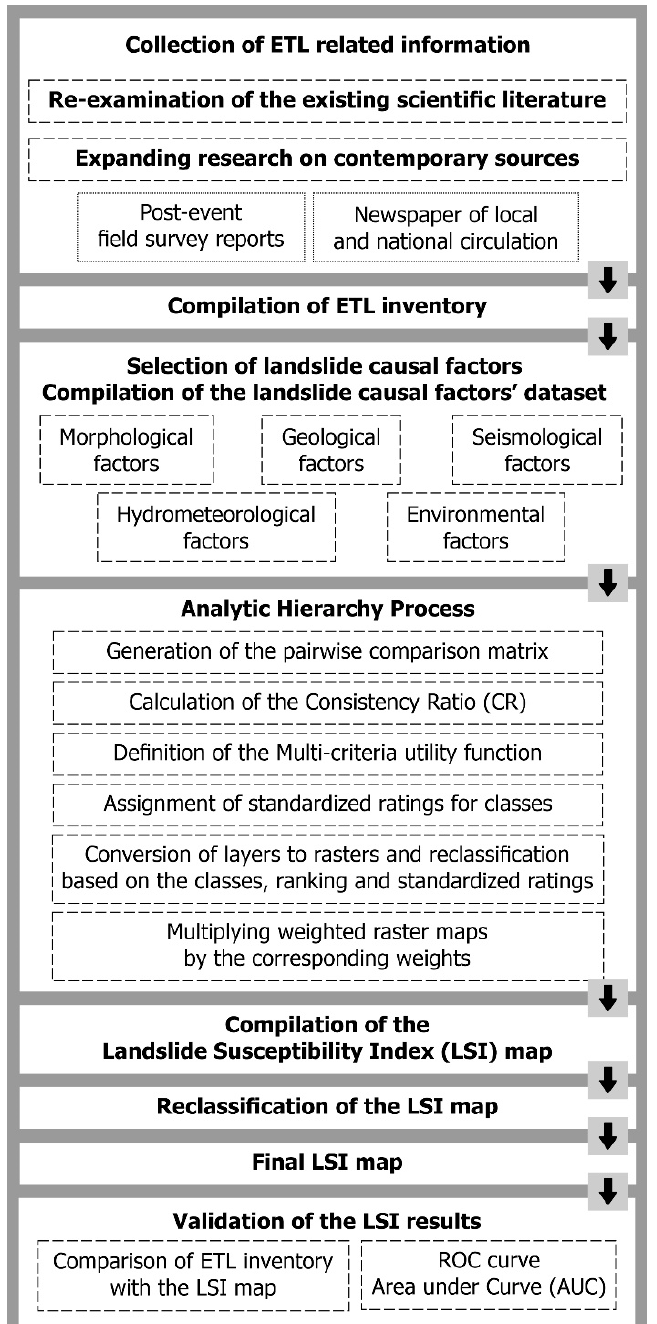
Figure 2. Flow chart showing the approach followed for the compilation of the ETL inventory and the respective landslide susceptibility assessment in Cephalonia.